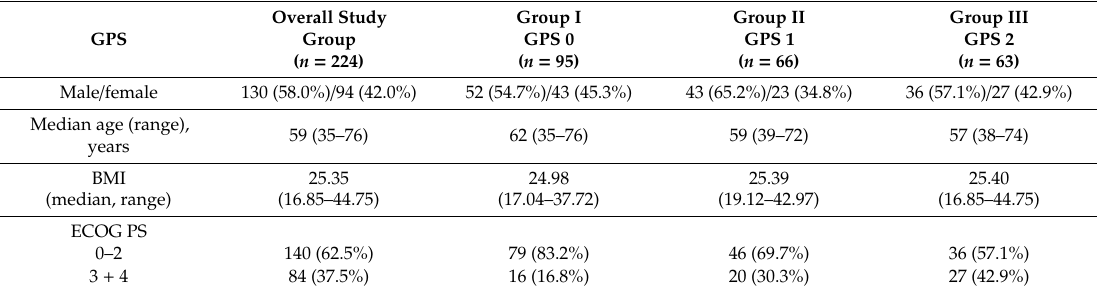
Table 1. Baseline characteristics for all patients included in the